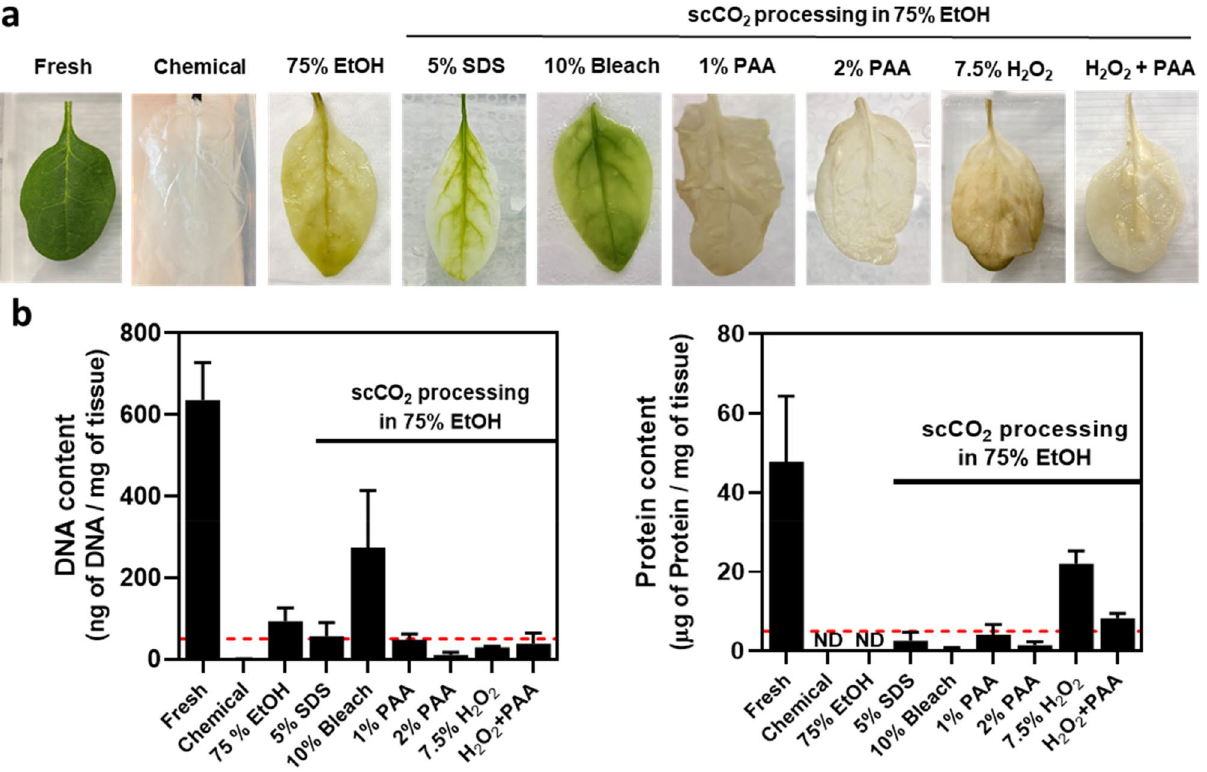
Figure 1. scCO 2 decellularization of spinach leaf. ( a ) Images of fresh, chemically treated and scCO 2 treated baby spinach leaves. scCO 2 processing was investigated with various co-solvents. ( b ) DNA and protein content of fresh, chemical treated and scCO 2 treated scaffolds. The dashed red lines indicate the decellularization threshold of 50 ng of DNA or 5 µg of protein per mg of tissue (data as mean ± SEM; n =